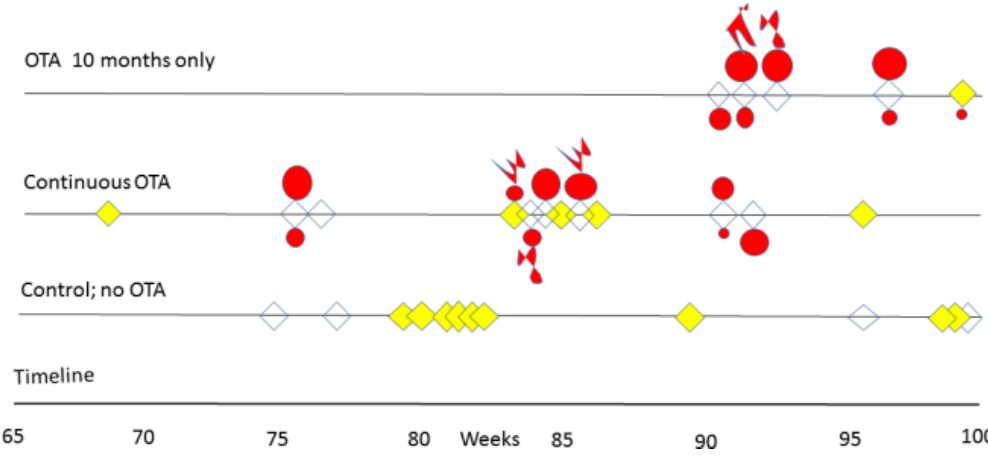
Figure 3. Course of outcomes for longevity, incidence of leukaemia, occurrence of renal tumours and distant metastases in male F344 rats given dietary ochratoxin A (300 µg/kg b.w.) from 8 weeks old continuously or for only 10 months, displayed from week 65 and compared with controls. Yellow indicates leukaemia, and red shows renal cancers with metastatic extension where appropriate.  Cryptic carcinoma (2  3 mm) in one